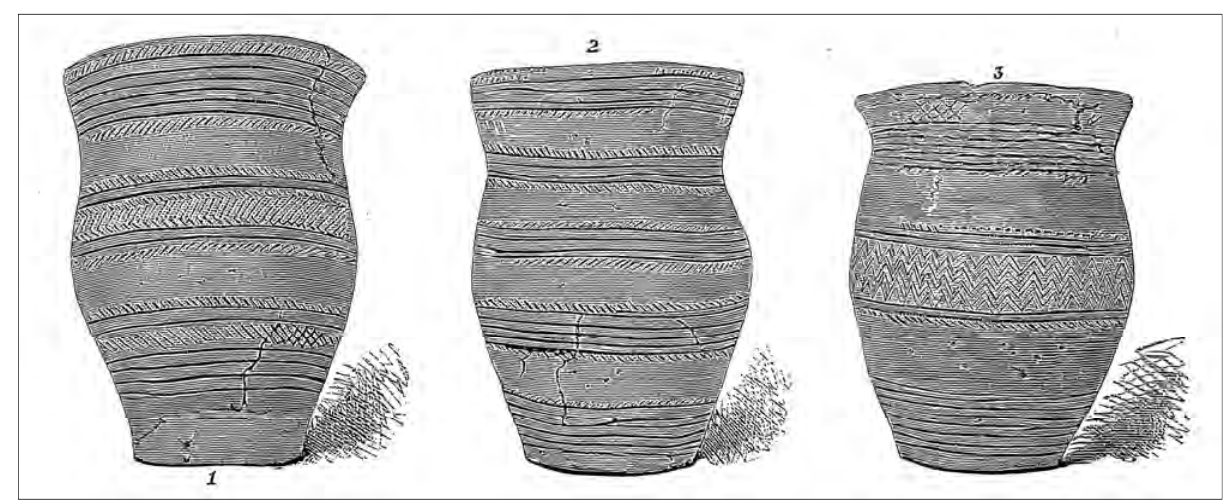
Fig 2.28 Beakers recovered from cists at Clifton, near Penrith, in 1880 (after Taylor